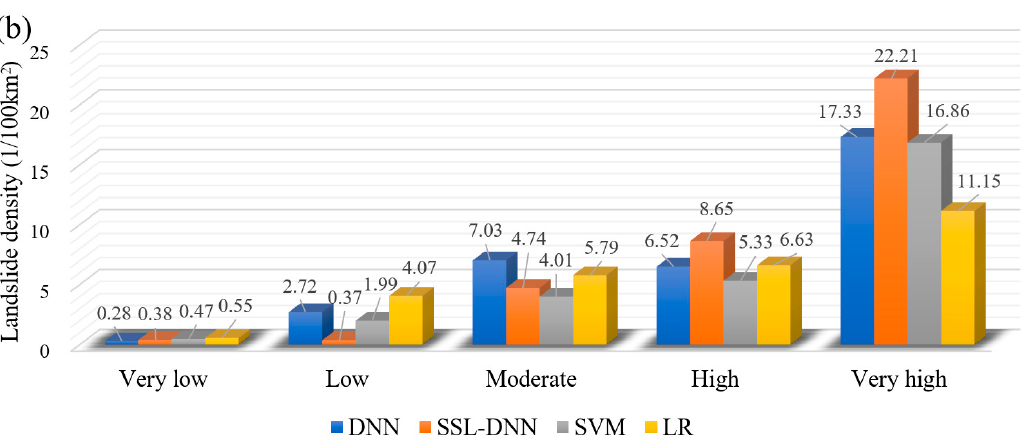
Figure 11. Comparison of the distribution using DNN, SSL-DNN, SVM, and LR models. ( a ) Total area covered by each susceptibility map; ( b ) Landslide density of each susceptibility class.